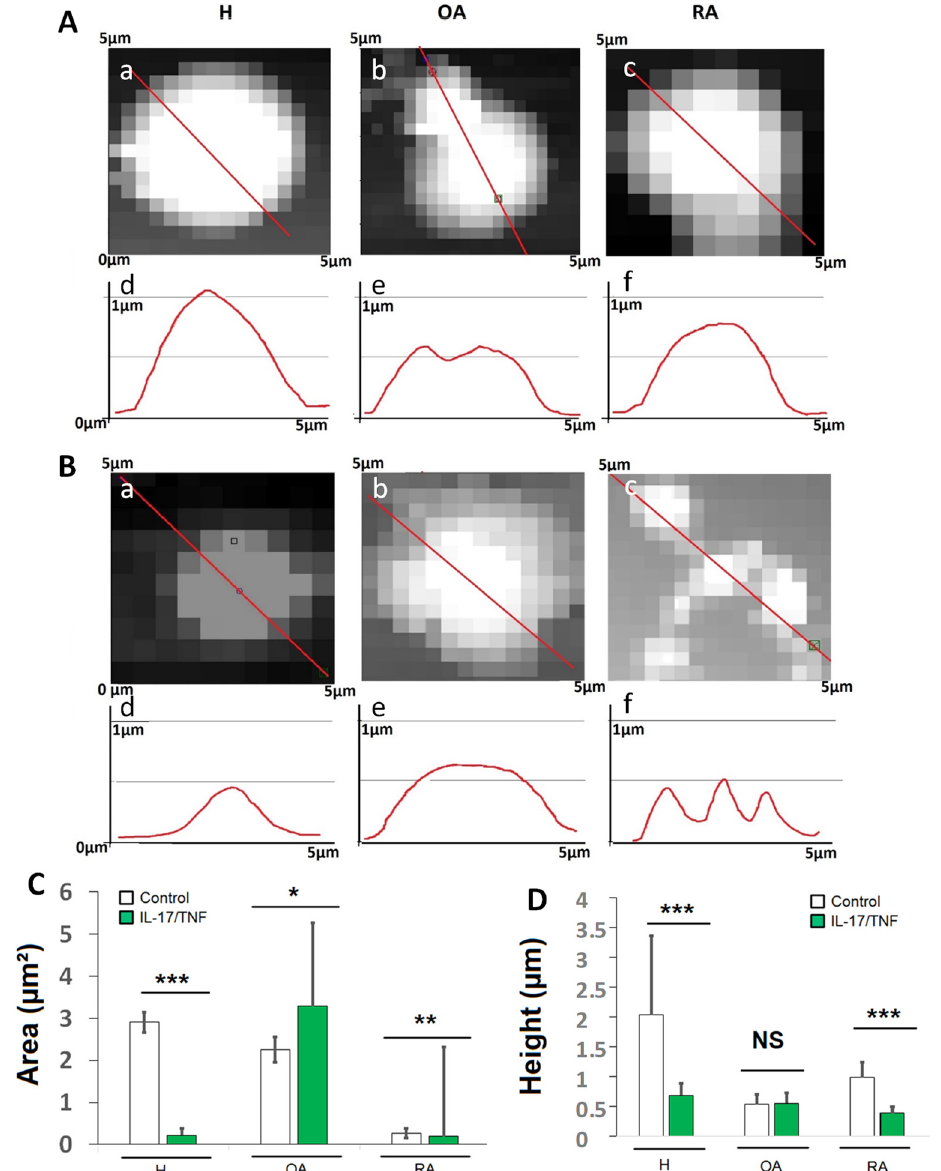
Figure 5. Characterization of vesicles from supernatants of healthy and pathological (OA and RA) FLS in the absence or presence of inflammatory environment (IL-17: 50 ng/mL, TNF- α : 1 ng/mL). Vesicle sectional curves and height topographies under standard ( A ) and inflammatory conditions ( B ). Differences in the height topographies ( a – c ) and sectional curves ( d – f ) depending on culture conditions were observed by Atomic Force Microscopy. Average vesicle area ( C ) and average height ( D ) as a function of pathology and inflammatory environment compared to control and represented by mean ± SEM and with ANOVA test *** p < 0.0001, ** p < 0.001 * p < 0.01 and NS non-significant.